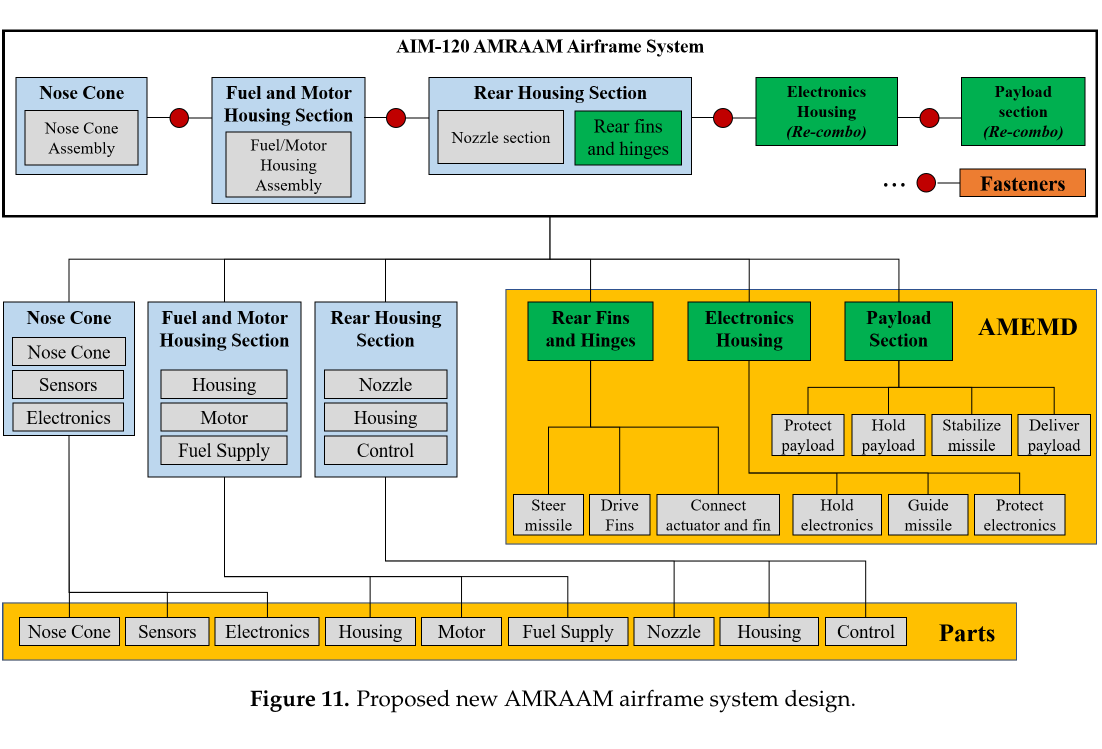
Figure 11. Proposed new AMRAAM airframe system design.